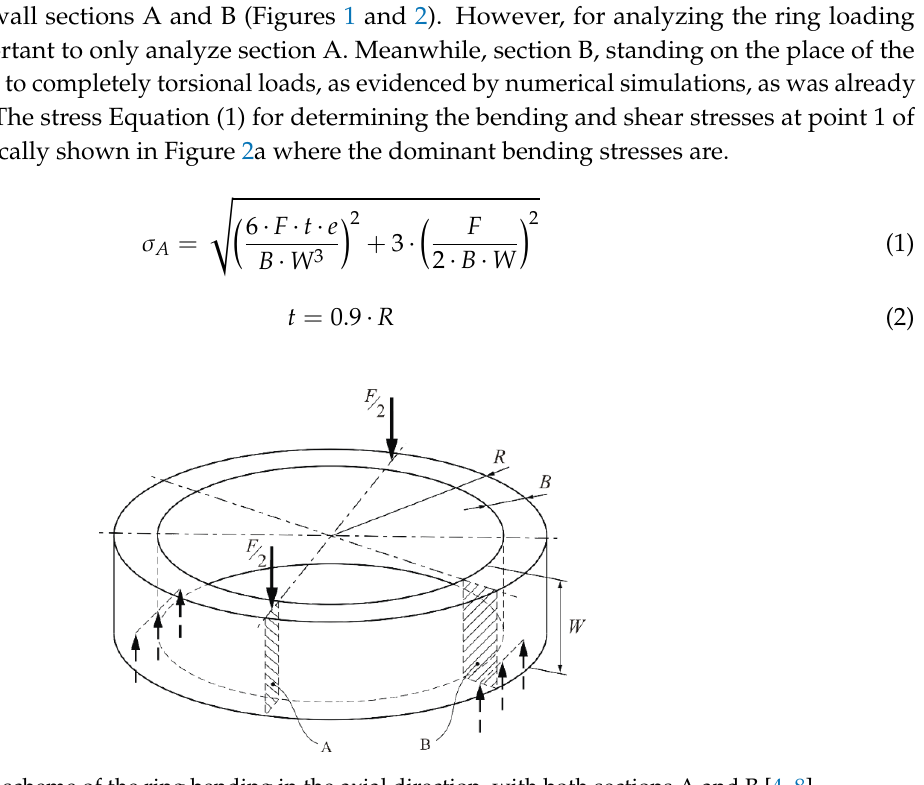
Figure 2. ( a ) Schematic view of the distribution of the bending stresses to the critical cross-section A and ( b ) schematic view of the distribution of both tangential and torsional stresses on the critical cross-section A [4–8].